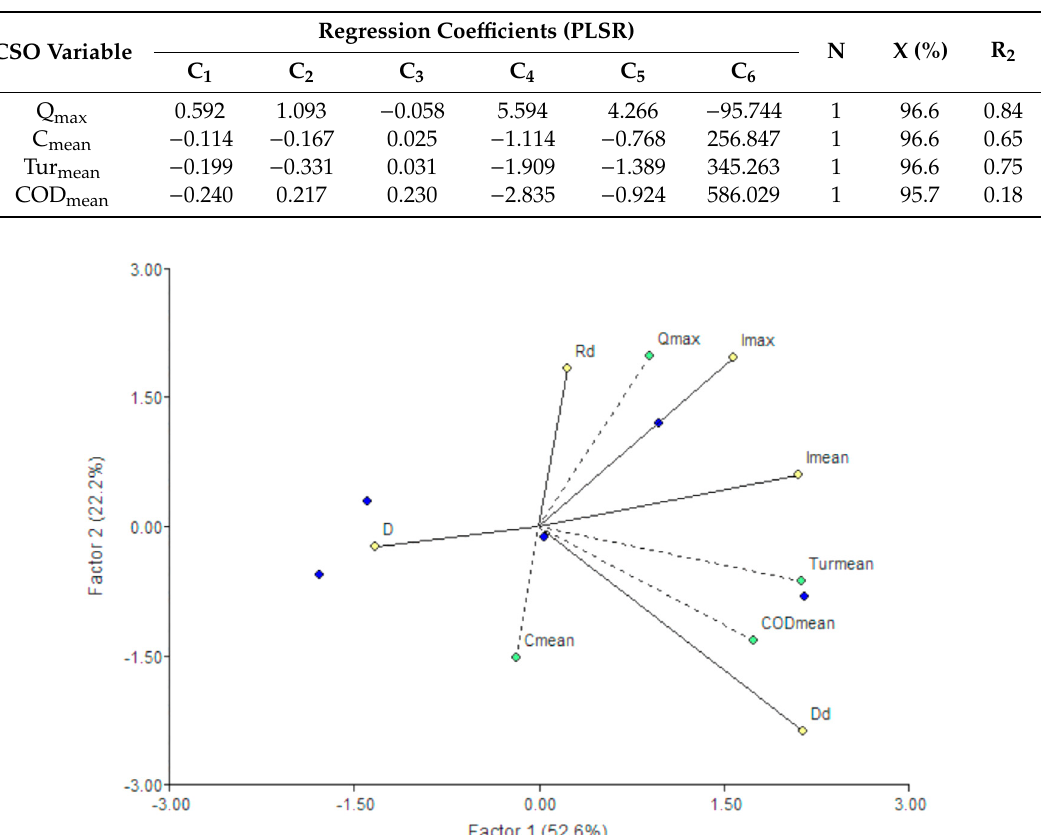
Figure A8. Triplot that represents the cases, the response variables and the predictor variables of the PLS model of the Multifamiliares CSO in the same graph.